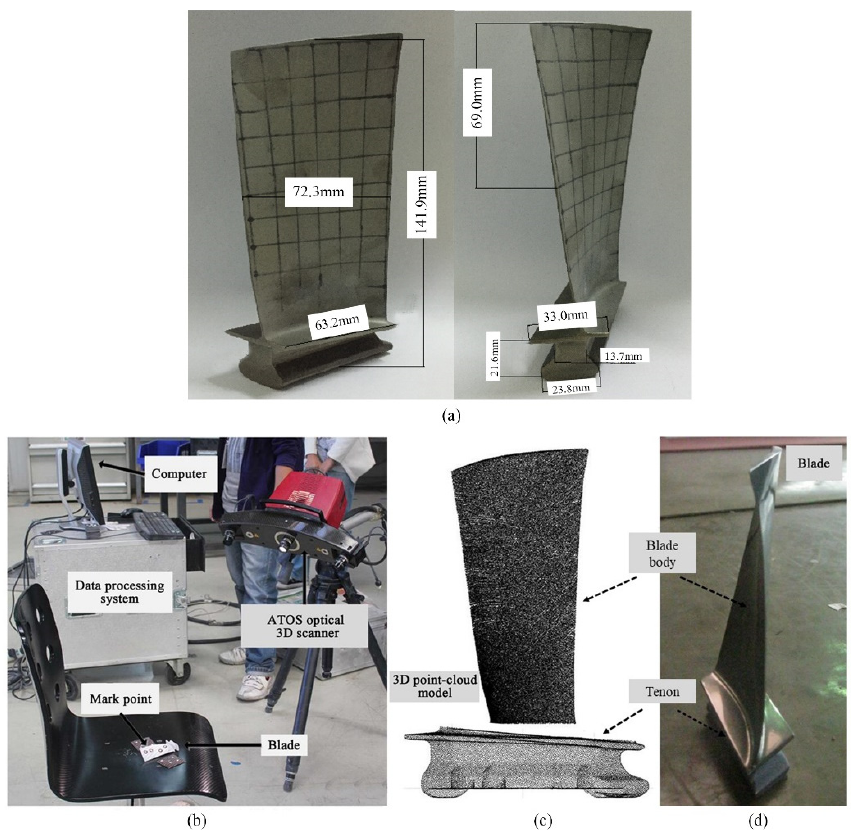
Figure 2. Blade geometry dimension and reversed modeling. ( a ) Geometric dimension of blade; ( b ) Blade geometry data acquisition; ( c ) Point cloud data block of blade; ( d ) Reference object.